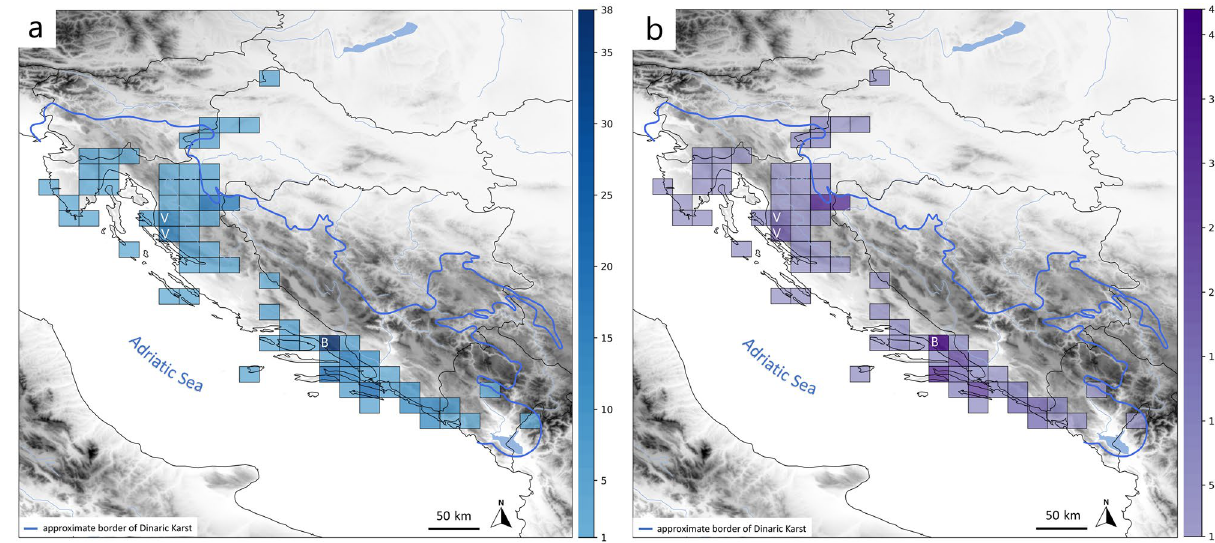
Figure 7. Species richness. ( a ) Species richness as sum of morphospecies. ( b ) Species richness as number of MOTUs in each cell. Areas without cells represent missing data. Abbreviations: V and B (Velebit and Biokovo Mountains). Map was made using Cartopy package ver. 0.19 (https:// scito ols. org. uk/ carto py/ docs/ v0. 18/ index. html) in Python ver.